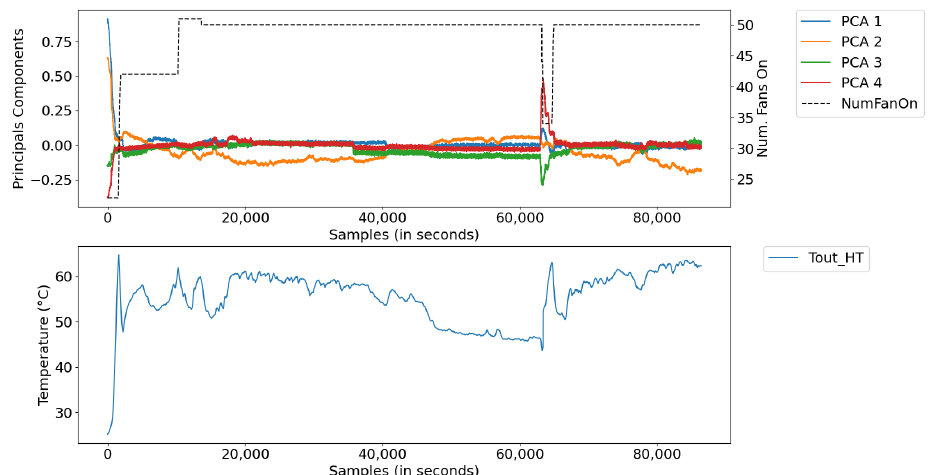
Figure 10. Number of fans, PCA components, and outlet